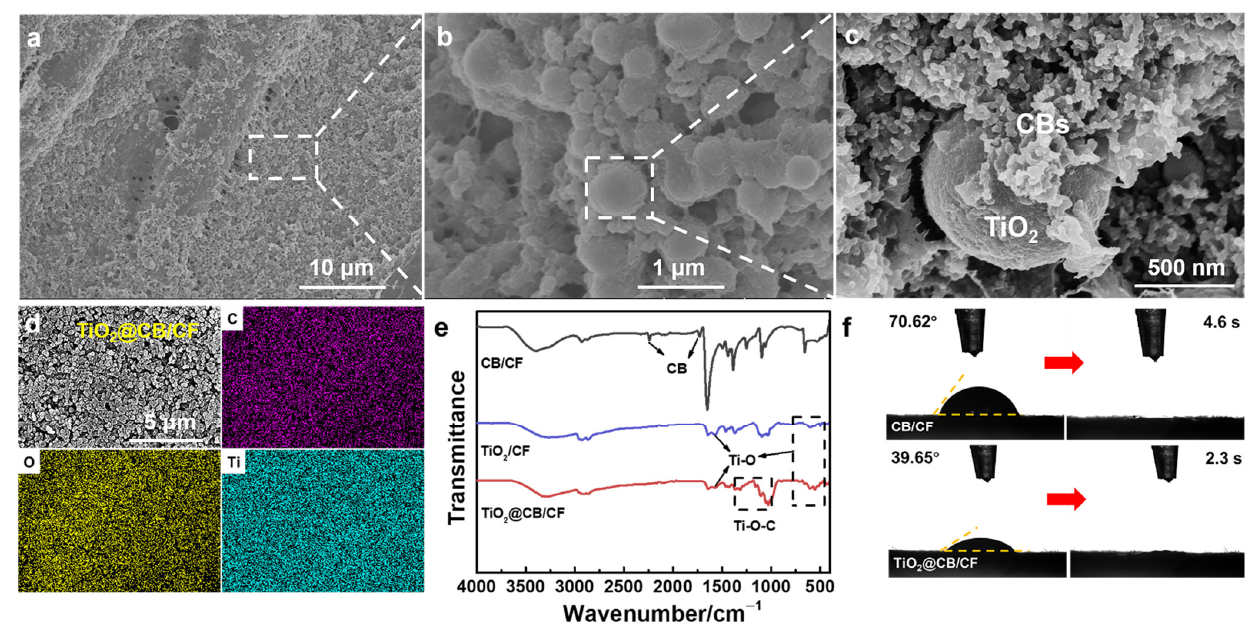
Figure 2. Morphologies and characterization of TiO 2 @CB/CF. ( a – c ) SEM images of TiO 2 @CB/CF. ( d ) EDS mapping images of TiO 2 @CB/CF. ( e ) FTIR spectra of CB/CF, TiO 2 /CF, and TiO 2 @CB/CF. ( f ) The water contact angle of CB/CF and TiO 2 @CB/CF.